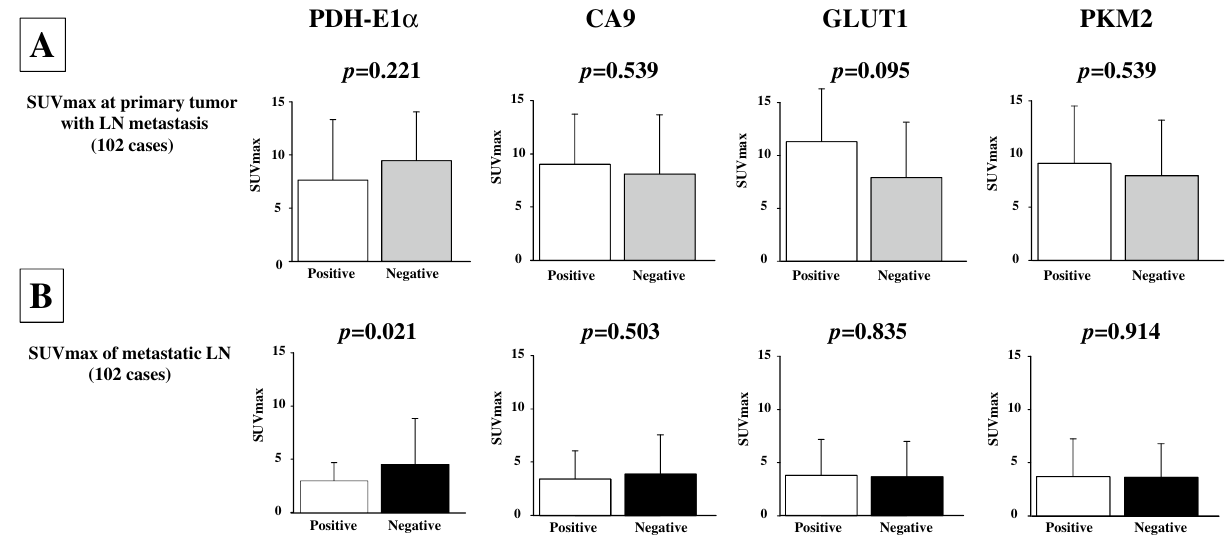
Figure 2. SUVmax of the primary lesion and metastatic lymph node according to the expression level of glucose metabolism enzymes. ( A ) Shows the SUVmax of primary tumors in 102 patients with lymph node (LN) metastasis. In contrast, there was no significant difference in the SUVmax of primary tumors according to the expression of glucose metabolism enzymes. ( B ) Shows the SUVmax of metastatic lymph nodes in all 102 patients. There is a significant difference in the SUVmax of metastatic lymph nodes according to the PDH-E1α expression, but not in GLUT1, CA9, and PKM2 expression. SUV, standard uptake value; PDH-E1α, pyruvate